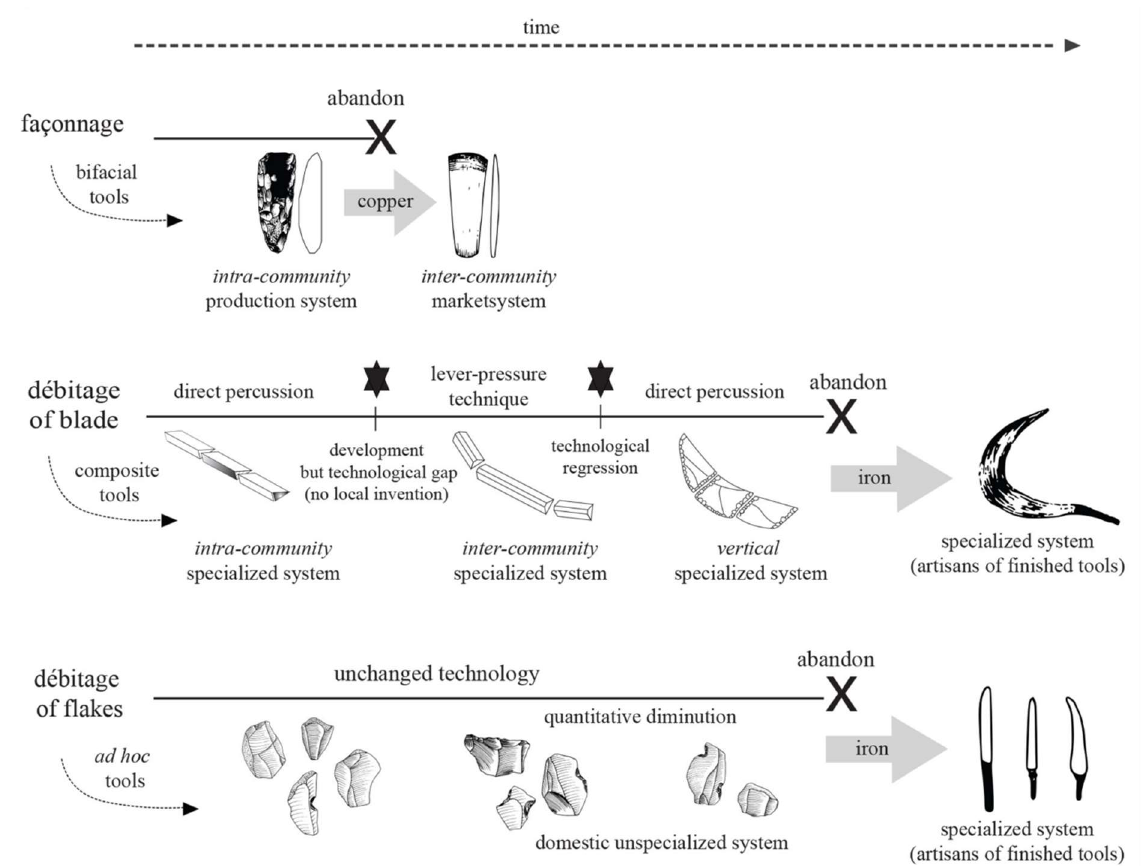
Figure 17. Three different production lineages (shaping, laminar débitage , flake débitage ) that were replaced by metal object lineages, following different trajectories and rhythms (Manclossi et al. 2019: fig.